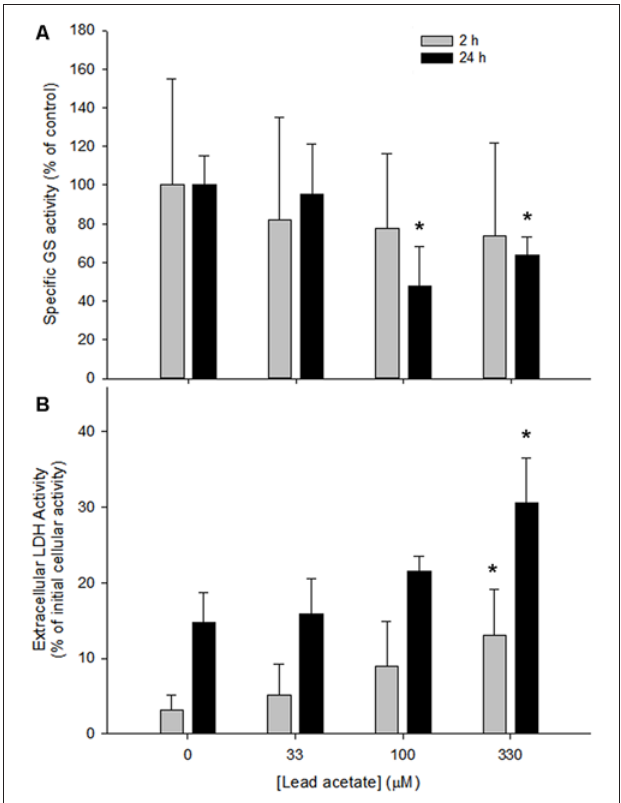
FIGURE 1 | Specific glutamine synthetase (GS) activity and cell viability in rat astrocyte cultures after 2 or 24 h incubation with four concentrations of lead acetate (0, 33, 100 and 330 µ M). (A) Specific GS activity expressed as a percentage of that in untreated cells. Each bar represents mean ± SD of n = 9 samples. (B) Cell death as determined by activity of Lactate dehydrogenase (LDH) released into the media. Each bar represents means ± SD of n = 6 samples. ∗ Significant differences between lead-treated and untreated cells at their respective timepoint ( p < 0.05).